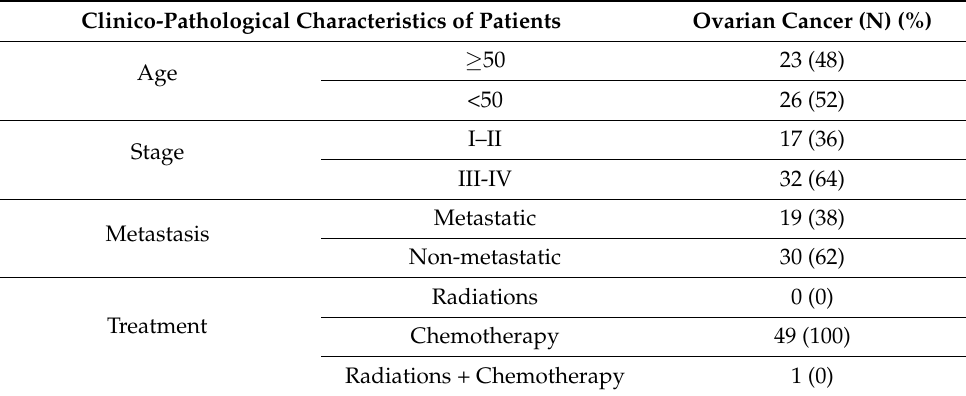
Table 2. Clinico-Pathological Characteristics of